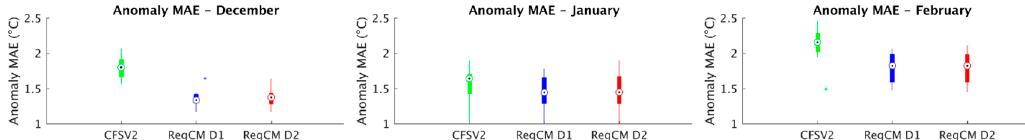
Figure 5. Temperature anomaly mean absolute error (MAE) for the CFSv2, RegCM-d1, and RegCM-d2, in green, blue, and red respectively. Box plots summarize the distribution built on the monthly MAE produced by each ensemble member considering its own climatology.